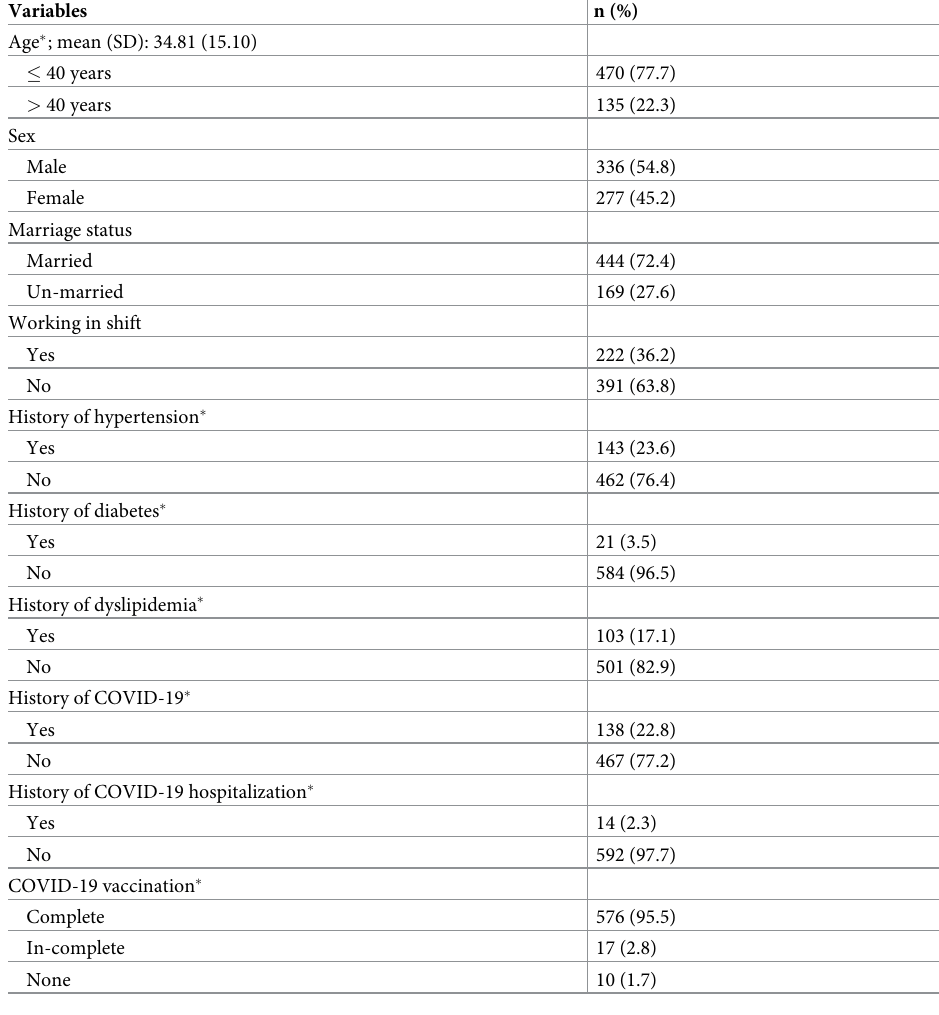
Table 1. Characteristics and health history of the university employees ( n = 613).